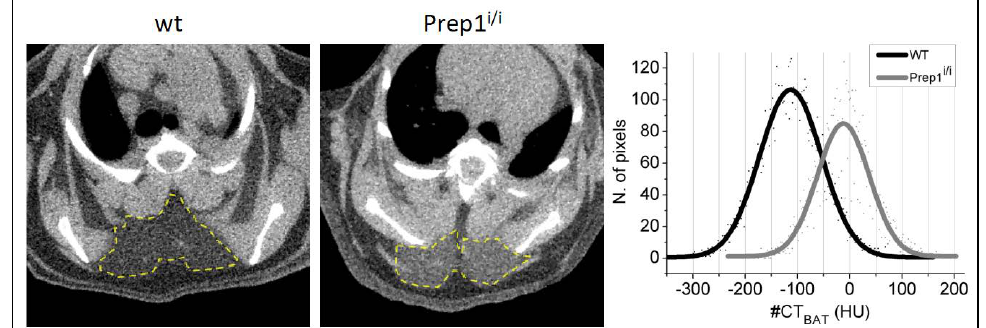
Figure 3. Hypomorph subjects show a higher density of the interscapular BAT than wt. Transaxial slices of the micro-CT scans. Figure shows density of interscapular BAT of the wt mouse (left) and the Prep1 i/i mouse (center). The histogram on the right panel shows the distribution of gray level intensities inside the highlighted BAT Region of Interest (ROI).